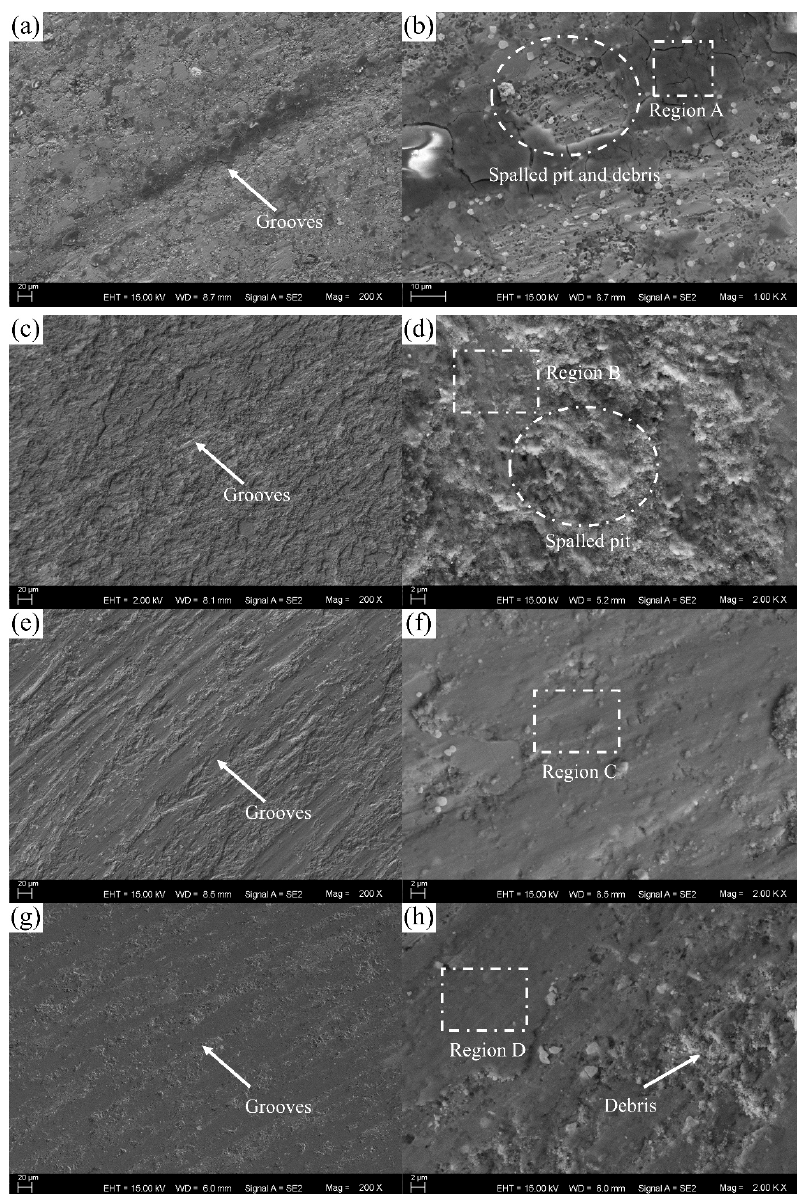
Figure 5. The worn surfaces of CoCrAlYTa-10%Al 2 O 3 coating at di ff erent temperatures: ( a , b ) 25 ◦ C; ( c , d ) 200 ◦ C; ( e , f ) 400 ◦ C; and ( g , h ) 600 ◦